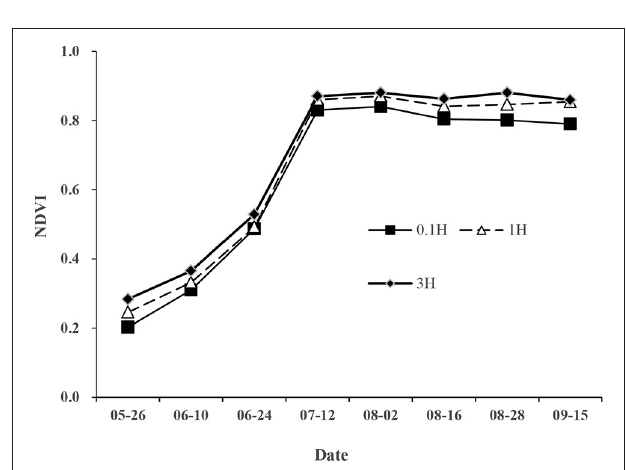
at 0.1H was < 1. The average K sw in the whole growth period at 0.1H, 1H, and 3H was 0.87, 1, and 1, respectively ( Figure 7A